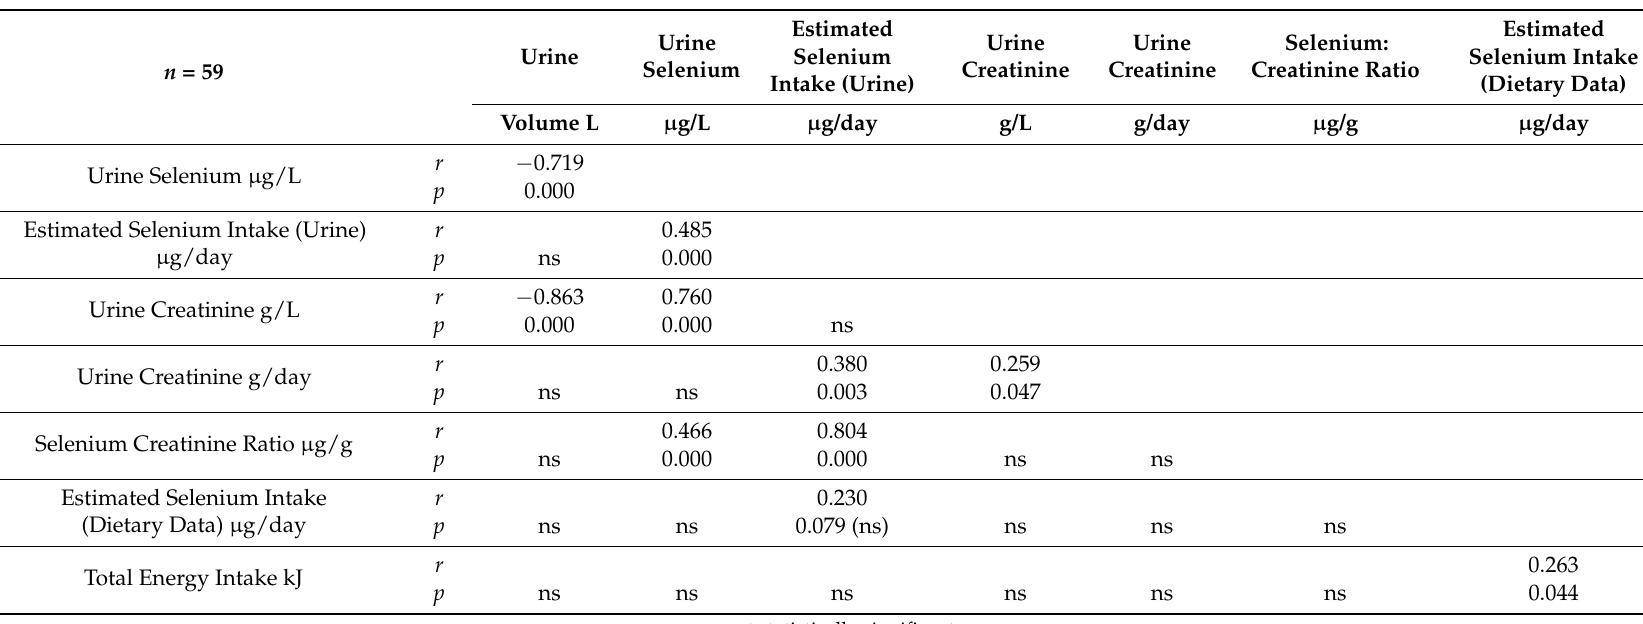
Table A1. Correlation matrix for selenium and creatinine in 24-h urine samples in pregnant women using Spearman’s rho.